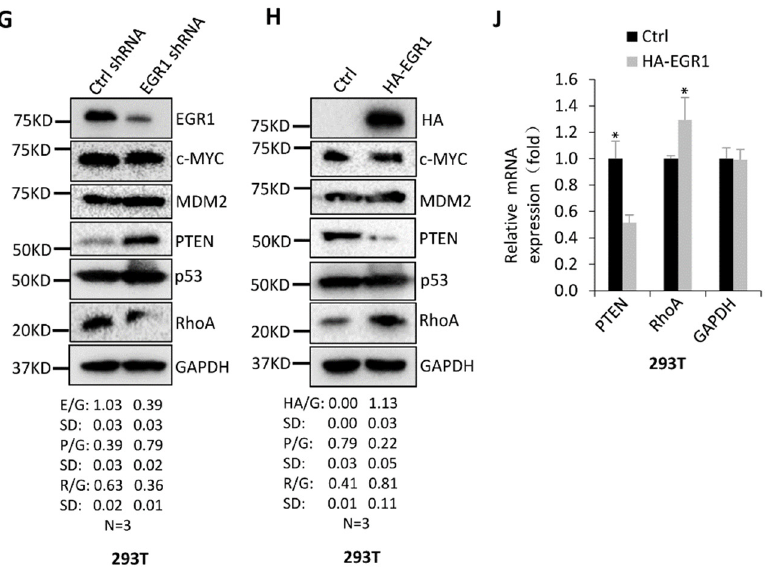
Figure 5. Alteration of EGR1 expression affected PTEN and RhoA expression: ( A – D ) ChIP assay results showing the effect of EGR1 on the occupancies of Pol III transcription machinery factors at the promoters of Pol III target genes. ChIP assays were performed using 293T cell lines stably expressing EGR1 shRNA and control shRNA and the antibodies against the factors, as indicated. The relative quantities of the DNA fragments at the loci of 5S rRNA ( A ), U6 RNA ( B ), 7SL RNA ( C ), and tRNA–Met ( D ) genes were detected by RT-qPCR. Relative enrichment was obtained by comparing the relative DNA quantity in a 1 µ L ChIP DNA sample to that of 0.01% input; ( E , F ) EGR1 expression change did not affect the expression of TBP, BRF1, and GTF3C2 in 293T cells. Western blotting was performed using 293T cell lines stably expressing EGR1 shRNA ( E ) and HA–EGR1 ( F ) and their control cell lines; ( G , H ) expression of oncogenic proteins, suppressors. and signalling factors in the 293T cell lines with EGR1 depletion ( G ) or overexpression ( H ) was examined by Western blotting; ( I , J ) expression of PTEN and RhoA mNA was monitored by RT-qPCR using the 293T cell line with EGR1 depletion or overexpression. E/G, H/G, P/G, and R/G in Western blot quantification, respectively represent the ratio of EGR1 (E), HA–EGR1 (H), PTEN (P), and RhoA (R) intensities to the GAPDH (G) intensity ( n = 3). Each column in the bar graphs represents the mean ± SD of three biological replicates ( n = 3). *, p < 0.05; **, p < 0.01. The p values of different genes or factors were obtained by Student’s t -test, performed with control and treatment